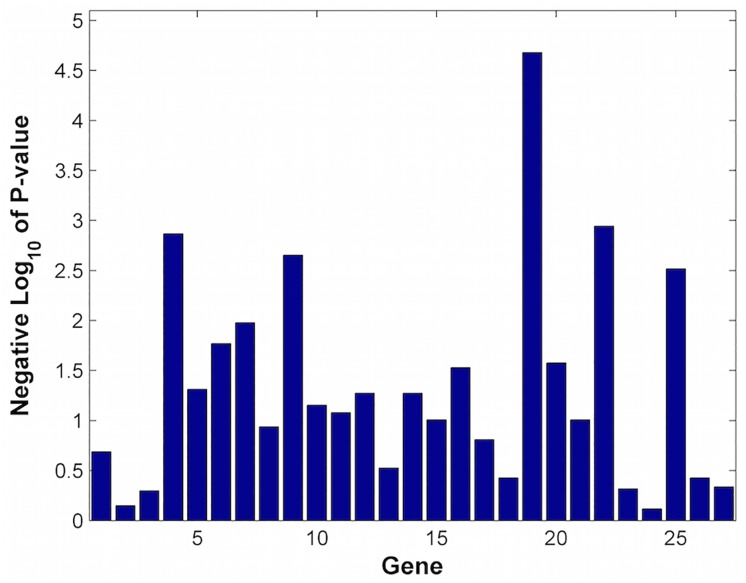
−log10(pvalue) of genes in REACTOME_PRE_NOTCH_TRANSCRIPTION_AND_TRANSLATION.The Wilcoxon rank-sum test is used to compute the p-values of each gene.